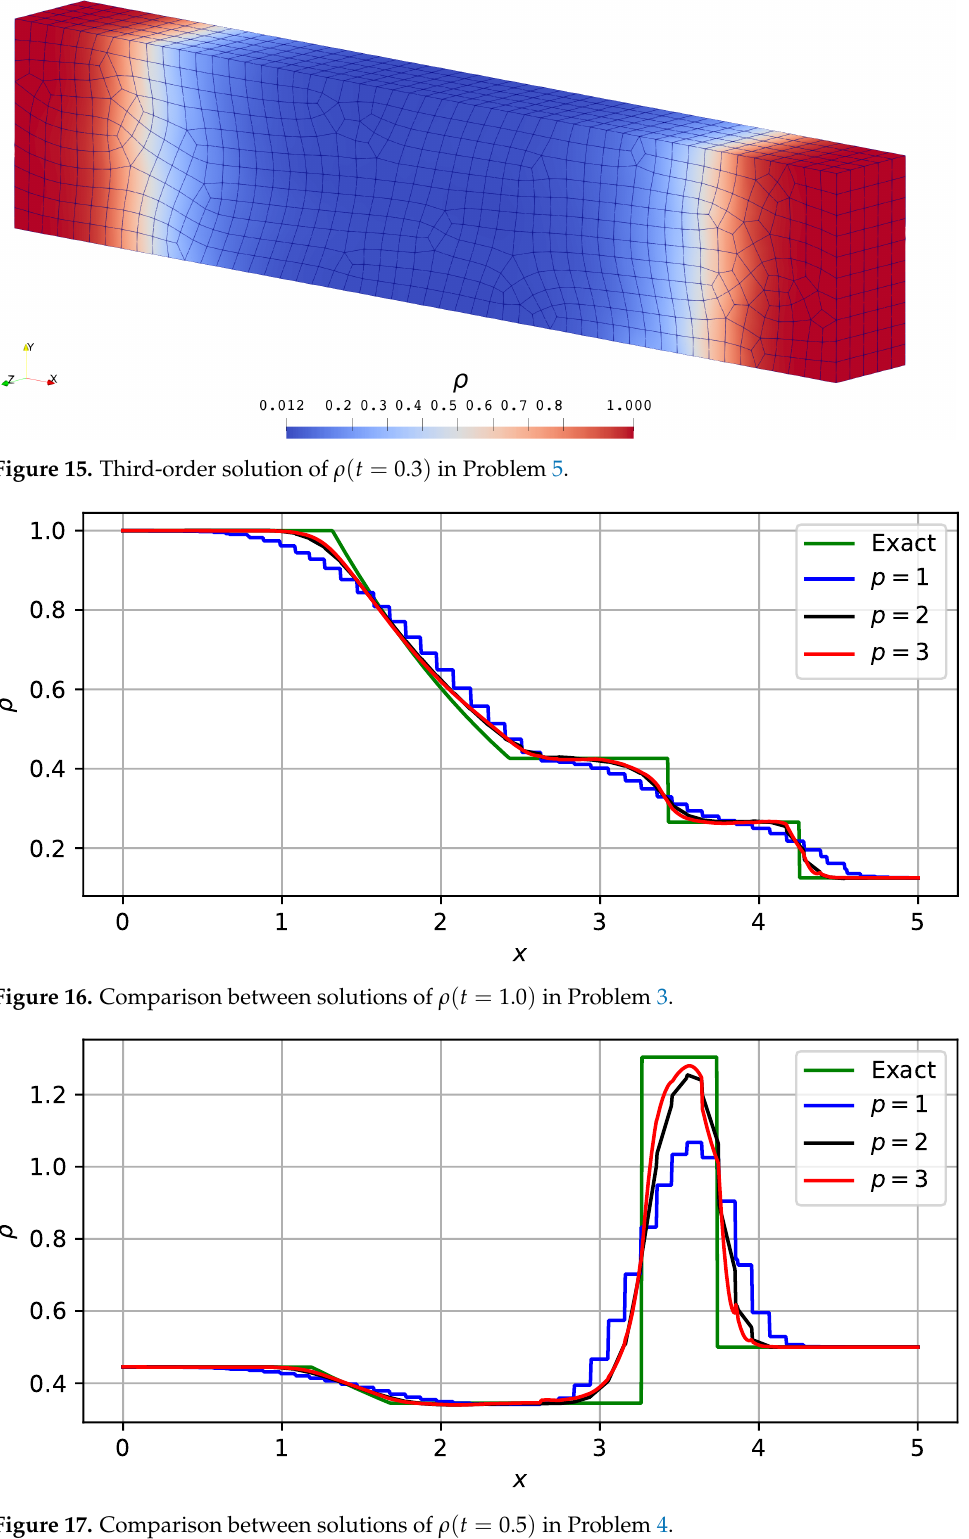
Figure 17. Comparison between solutions of ρ ( t = 0.5 ) in Problem